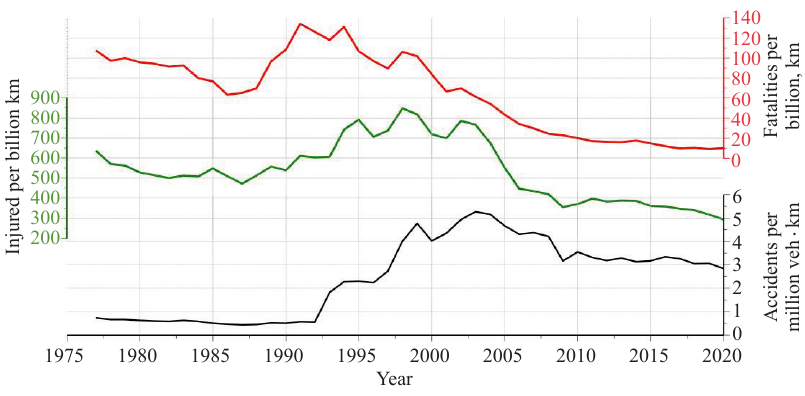
Figure 14. Accident rate, fatalities and number of injured per vehicle mileage in